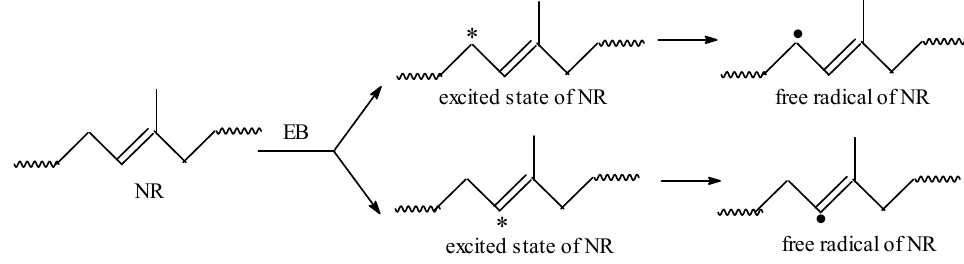
Figure 3. Scheme of the obtaining of NR macro-radicals by EB irradiation.